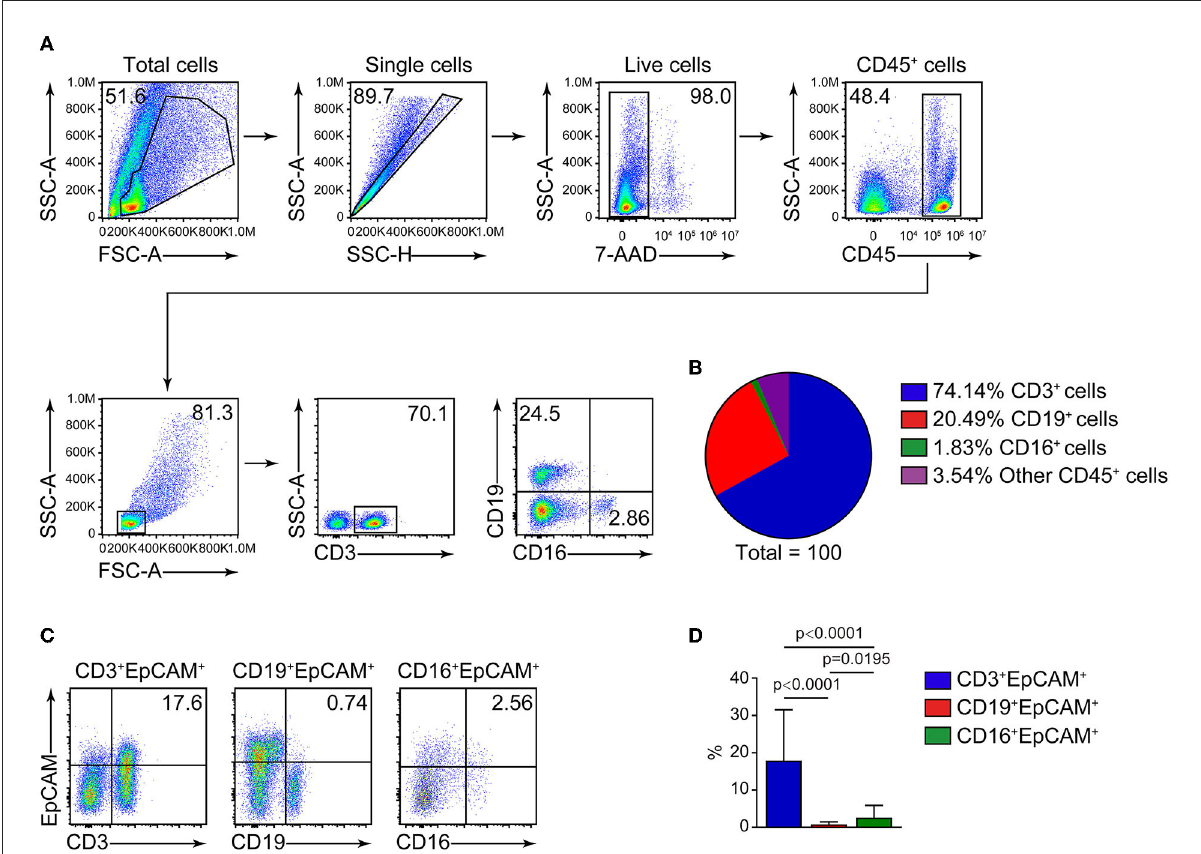
FIGURE1 FACS analysis of cells in lung cancer tumor tissues. (A) Representative flow cytometry plots of CD3 + , CD19 + , CD16 + cells analysis from tumor cells of patients with lung cancer. (B) Summary of the ratio of CD3 + , CD19 + , CD16 + cells ( n = 29). (C) Flow cytometry analysis of CD3 + EpCAM + , CD19 + EpCAM + , CD16 + EpCAM + cell ratio (gated on 7AAD − CD45 + cells) in tumor cells from patients with lung cancer. (D) Quantification data on the ratio of CD3 + EpCAM + , CD19 + EpCAM + , CD16 + EpCAM + cells ( n =